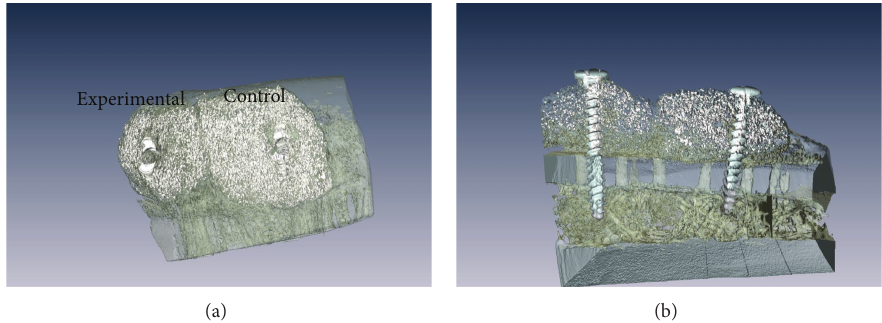
Figure 3: Three-dimensional reconstruction of the mandibular segment containing both experimental and control blocks. (a) Lateral view of the onlays depicted bone ongrowth on the lateral aspects of both blocks. (b) The cross-sectional reconstruction showed the perforations performed in the mandibular lateral aspect cortical (arrows). Bone ingrowth was observed at the region in immediate contact with the mandibular bone for both blocks; bone ingrowth throughout the volume of the block was only observed for the experimental group, which also presented lower amounts of synthetic material compared to the control